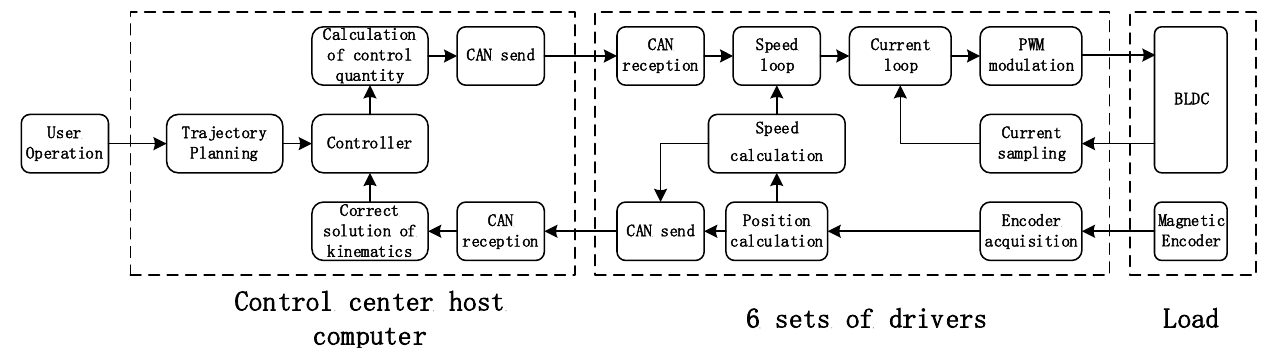
Figure 2. Functional design block diagram of the parallel platform control system.